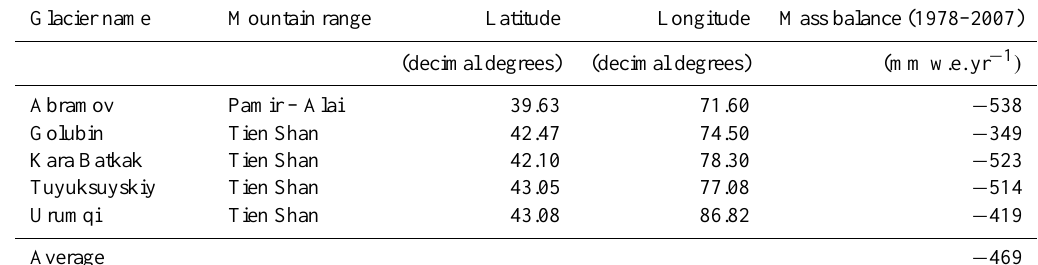
Table 2. Observed mass balance data since for 1978–2007 for five glaciers in the study area (WGMS, 2011). Glacier